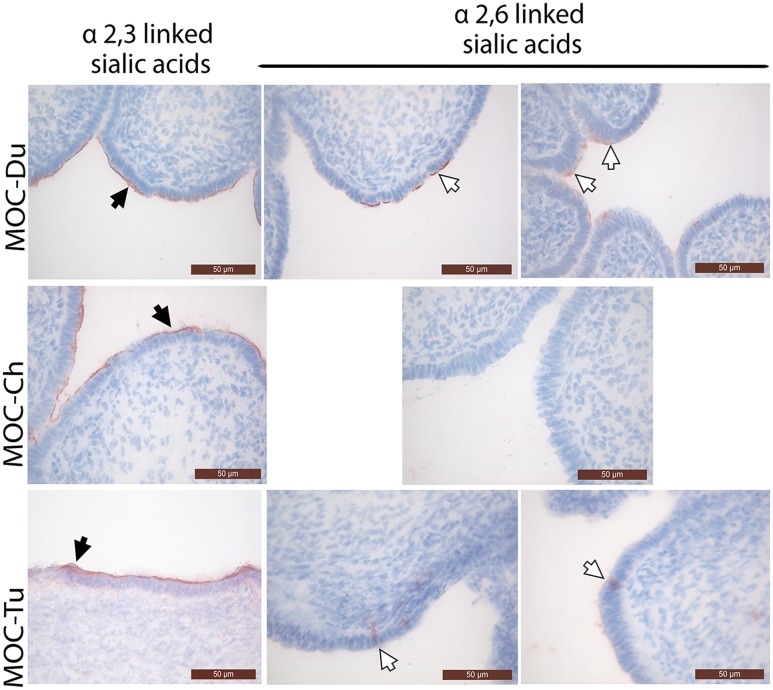
Lectin staining of α2,3 linked sialic acids and α2,6 linked sialic acids in magnum organ cultures (MOC) of Pekin duck (Du), chicken (Ch), and turkey (Tu) (Experiment 1). Virus-free MOC were snap-frozen and processed for lectin staining. White arrows indicate α-2,6 linked sialic acids which were detected with the biotinylated Sambucus nigra lectin (SNA). Black arrows indicate α2,3 linked sialic acids which were detected with the biotinylated Maackia amurensis lectin II (MAL II). Peroxidase activity was developed with the AEC Peroxidase Substrate. The slides were counterstained with hematoxylin. Data from MOC of two different animals are shown for duck and turkey.